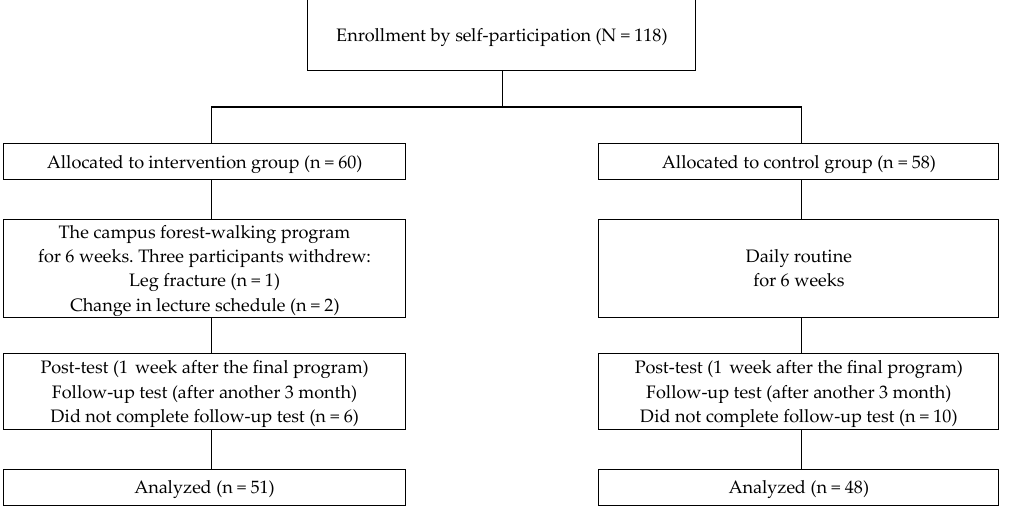
Figure 1. Recruitment of participants